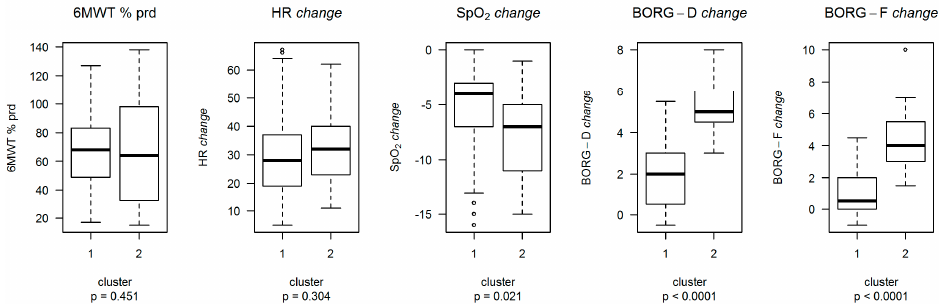
Figure 2. Boxplots describing the distribution of variables used for the analysis by cluster. From top to bottom, each boxplot represented: the lower non-outlier limit, the 25th percentile, the 50th percentile, the 75th percentile, and the upper non-outlier limit. Each point outside of the non-outlier range represents an outlier with respect to the variables’ distribution. p = p -value deriving from the Wilcoxon rank-sum test. When focusing on the variables that were not used for cluster definition, we observed that compared to C1, the individuals in C2 were older, more likely to be affected by renal failure and COPD, and had higher baseline Borg-D, end-exercise Borg-D, end-exercise Borg- F, and lower HR peak (Table 2). Table 2. Results from testing for differences in variables distribution between clusters.